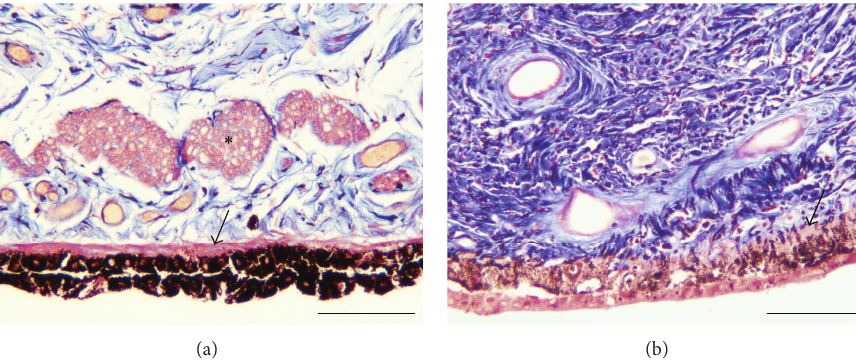
Figure 3: (a) Control horse. Normal portion of the posterior surface of the pupillary margin of the iris with both the dilator muscle (arrow) and sphincter muscle present (asterisk). Masson’s trichrome. Bar = 200 𝜇 m. (b) Horse B. Posterior surface of the iris with thin dilator muscle (arrow); the sphincter muscle was absent. Note also the poorly pigmented and disorganized epithelium on the posterior surface of the iris. Masson’s trichrome. Bar = 200 𝜇